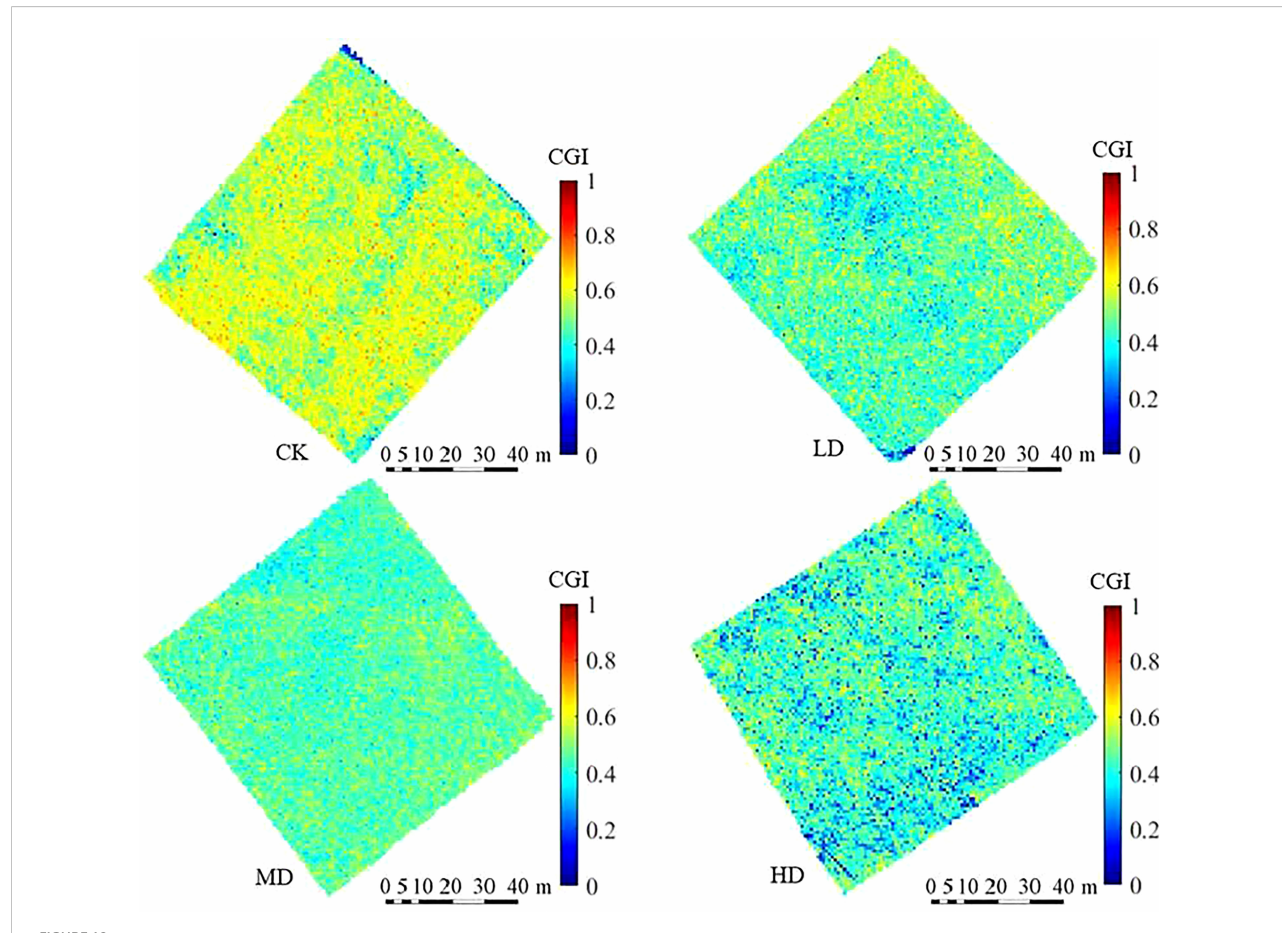
FIGURE 10 Inversion results of CGI grassland vegetation in four study areas.